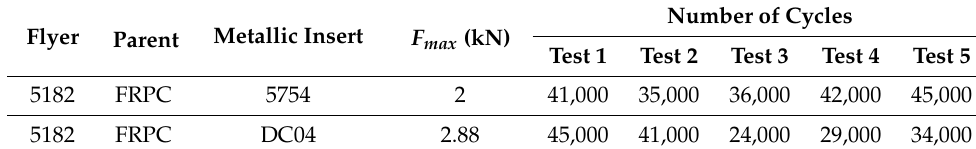
Table 7. Dynamic lap-shear tests for metallic insert configuration (E = 16 kJ).